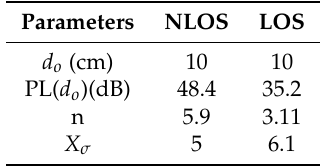
Table 4. Channel model parameters. NLOS,